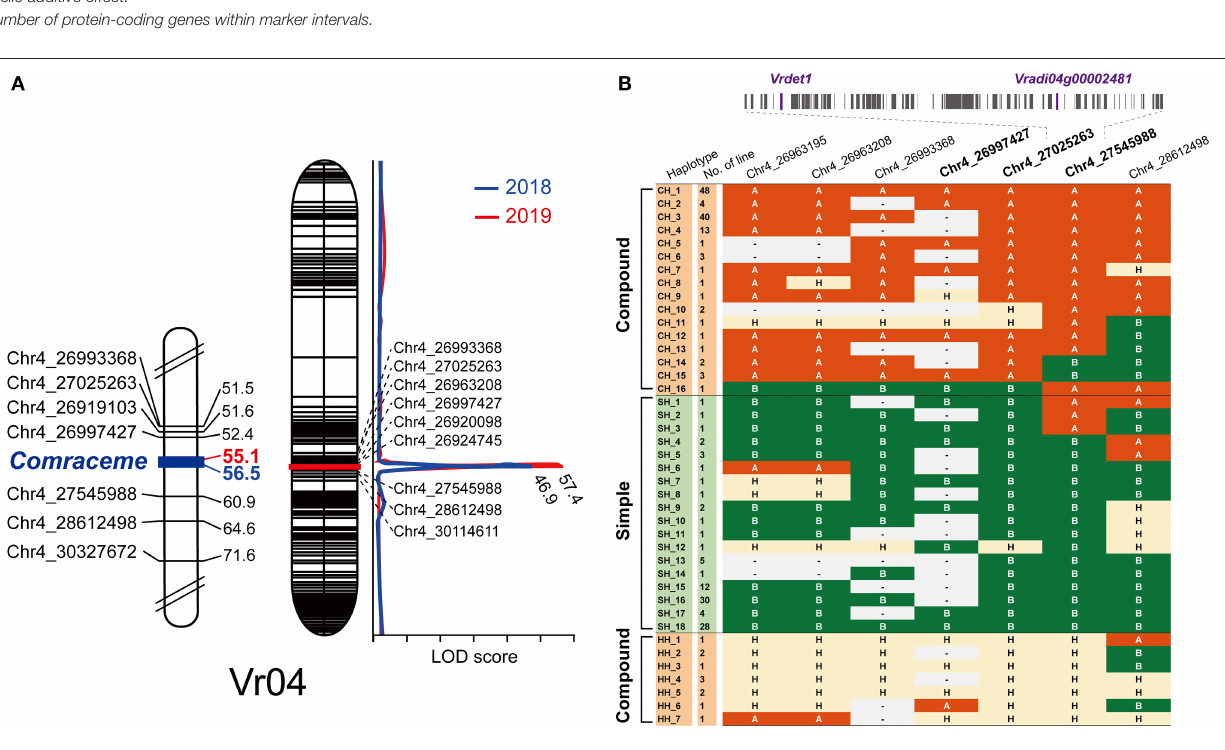
haplotypes CH_16 and SH_1 had the same alleles at both marker positions but produced compound and simple raceme inflorescences, respectively. This suggested the recombination break occurred between Chr4_27025263 and Chr4_27545988,